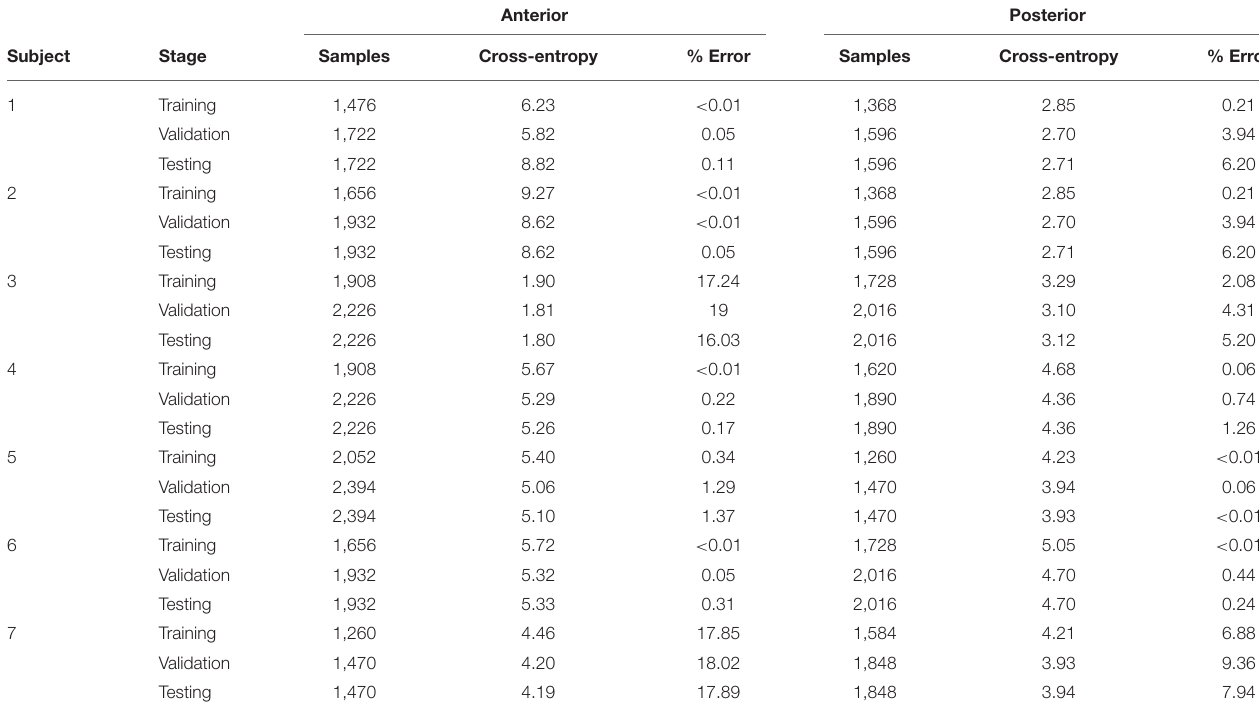
TABLE 3 | Parameter distribution and the resulting cross-entropy and percentage error measures from supervised Levenberg-Marquardt validation (Matlab routine) on the two ROIs: Anterior and posterior musculature. Anterior Posterior